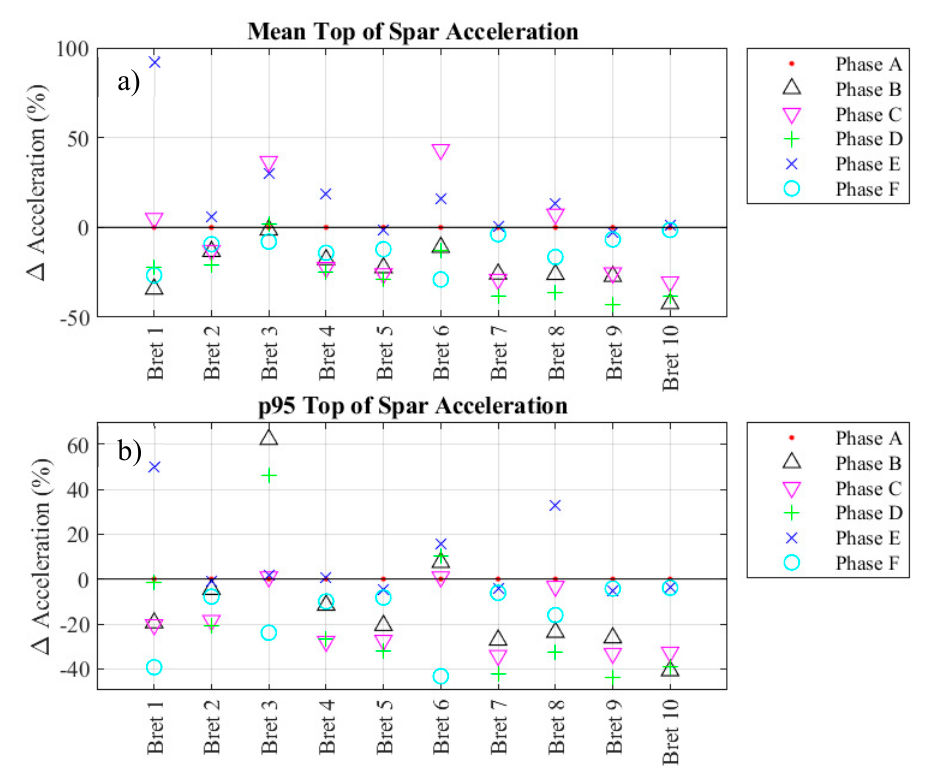
Figure 13. Relative changes in response acceleration between phases for Bretschneider wave excitation in terms of ( a ) mean values and ( b ) 95th percentile values.